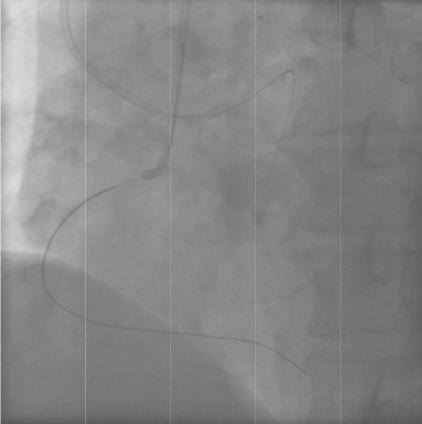
Figure 3: Retrograde guidewire was passed from the subintimal space to reach the proximal RCA true lumen and into the antegrade guiding catheter.